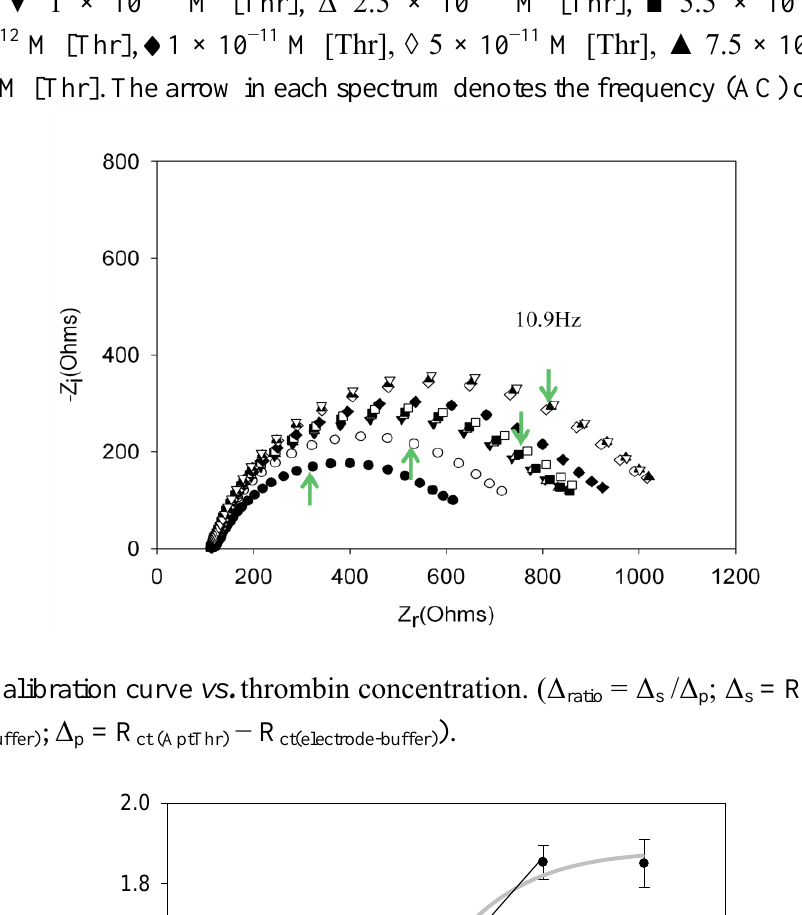
Figure 6. Nyquist diagrams for different concentrations of thrombin. ● Electrode-buffer, ○ AptThr, ▼ 1 × 10 −12 M [Thr], Δ 2.5 × 10 −12 M [Thr], ■ 5.5 × 10 −12 M [Thr], □ 7.5 × 10 −12 M [Thr],